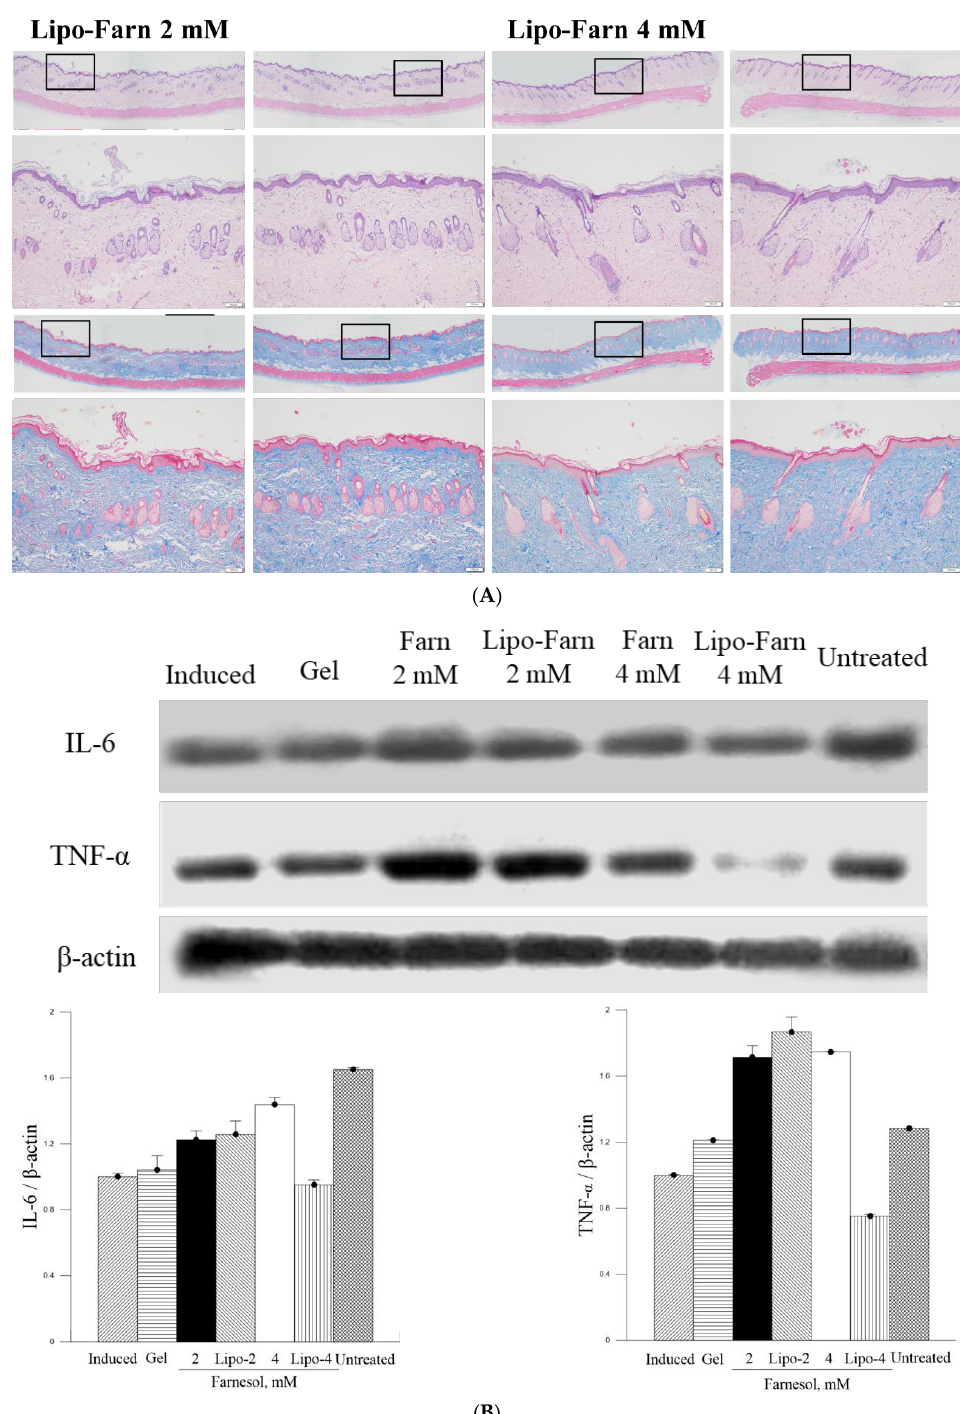
Figure 6. ( A ) H & E and Masson’s trichrome staining for the groups in continuous PM 2.5 subcutaneous injection and simultaneous treatment category. In the histopathological analysis, different lesions caused by PM 2.5 were observed as follows. 1. Epidermal erosion, loss of keratin, parakeratosis coupled with hyperkeratosis. 2. Epithelial and follicle cysts arising from injured pilosebaceous units. 3. Rupture of the cyst lining, accumulation of exudates and keratin-like substance in the epidermis. 4. Inflammatory cell and fibroblast infiltration. 5. Fragmented, loose extracellular matrix and loss of extracellular collagen-like substance. Bar: 100 µ m. ( B ) Western blot analysis of IL-6 and TNF- α . The rat skin specimens were collected from the groups treated with or without gel, Farn, and Lipo-Farn after the subcutaneous injection of PM 2.5 . (Continuous PM 2.5 subcutaneous injection and simultaneous treatment